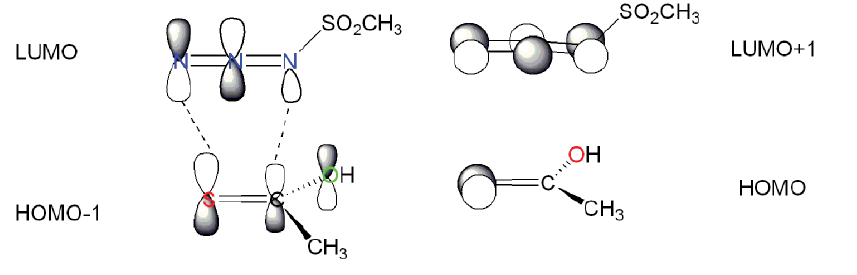
Scheme 5. Interaction between the occupied and the unoccupied orbitals of the azide and the thioacid in reaction